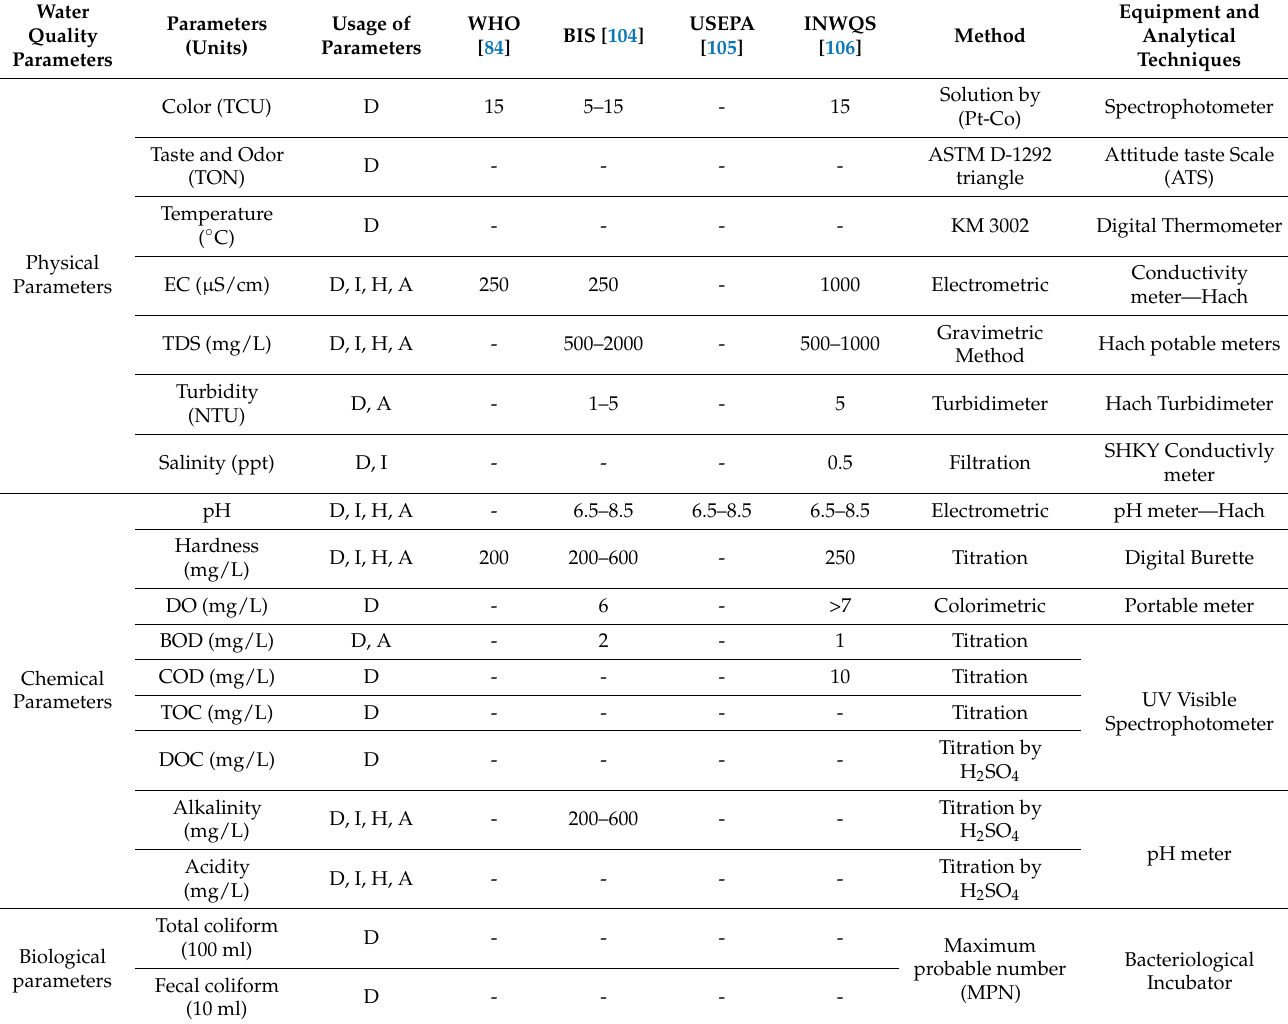
Table 2. The table listed suitable analytical methods and equipment using the physicochemical parameter’s national and international standard evaluation